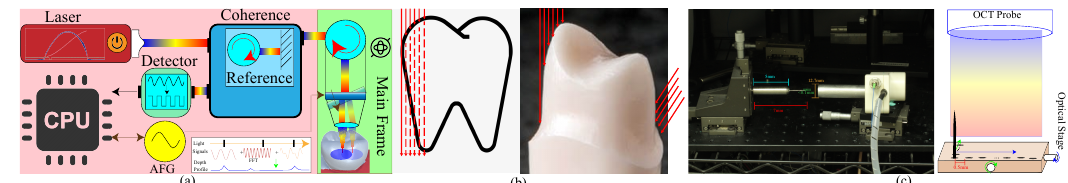
Figure 2. ( a ) Our optical coherent tomography (OCT) device consists of a scanning probe and a main frame while both are connected with an optical fiber. The main frame generates infrared rays of various frequencies, controls the scanning direction, transforms and processes the receiving coherent responses, stitches multiple scans, and reconstructs the tooth while the probe targets rays at the destined region, collects their responses, and tracks the scanning posture. ( b ) Because the injector has a small caliber, it cannot cover the entire tooth. It has a short operation range, and it cannot penetrate the entire tooth as shown in the left. Additionally, the light scatters when it is far from the source to limit its operation range, and thus, the top-down scanning in the right cannot precisely reconstruct the surface and we should scan it from the side. ( c ) The left shows the snapshot of our calibration setting with a manually moving stage and the probe, and the right is the multi-shot calibration scheme, where the needle is placed at designated grid points with a spacing of 0.5